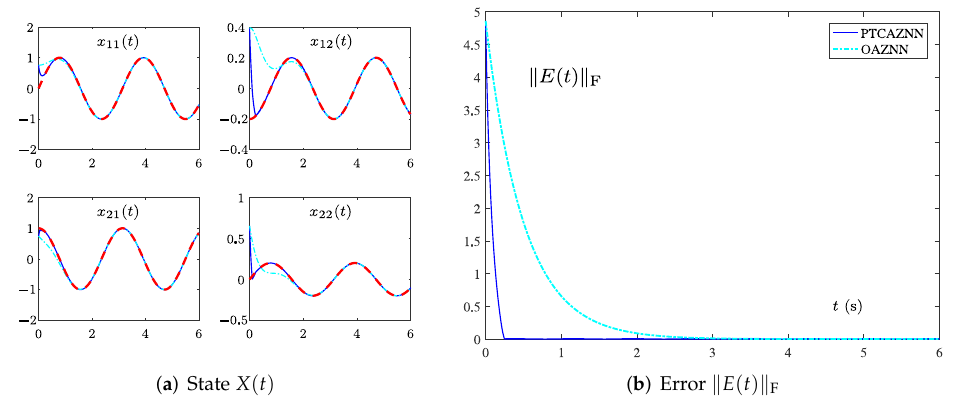
Figure 1. Simulation results by the OAZNN model (11) and PTCAZNN model (15) with λ = 2 for TVMIP of (40) in the absence of noise. Table 2. Convergence time (CT) of the OAZNN model and PTCAZNN model in the absence of noise < 10 − 2 ). (the convergence accuracy is (cid:107) E ( t ) (cid:107) F PTCAZNN Model Parameter OAZNN Model Theoretical Practical CT Computing CT λ =